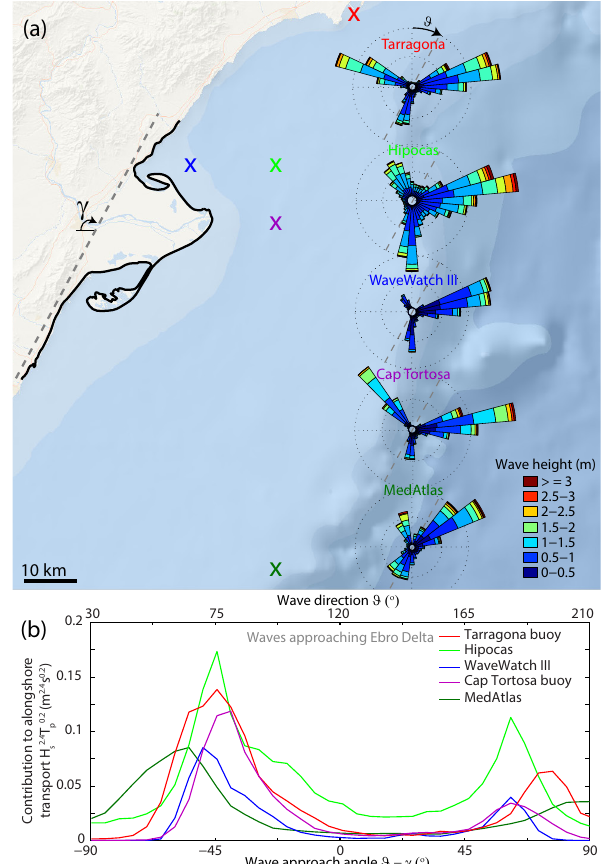
Figure 3. (a) Comparison of the five different wave roses and their location on a map from NOAA (2015). See Table 2 for an overview of the sources. (b) Angular distribution of alongshore sediment transport potential for the five different